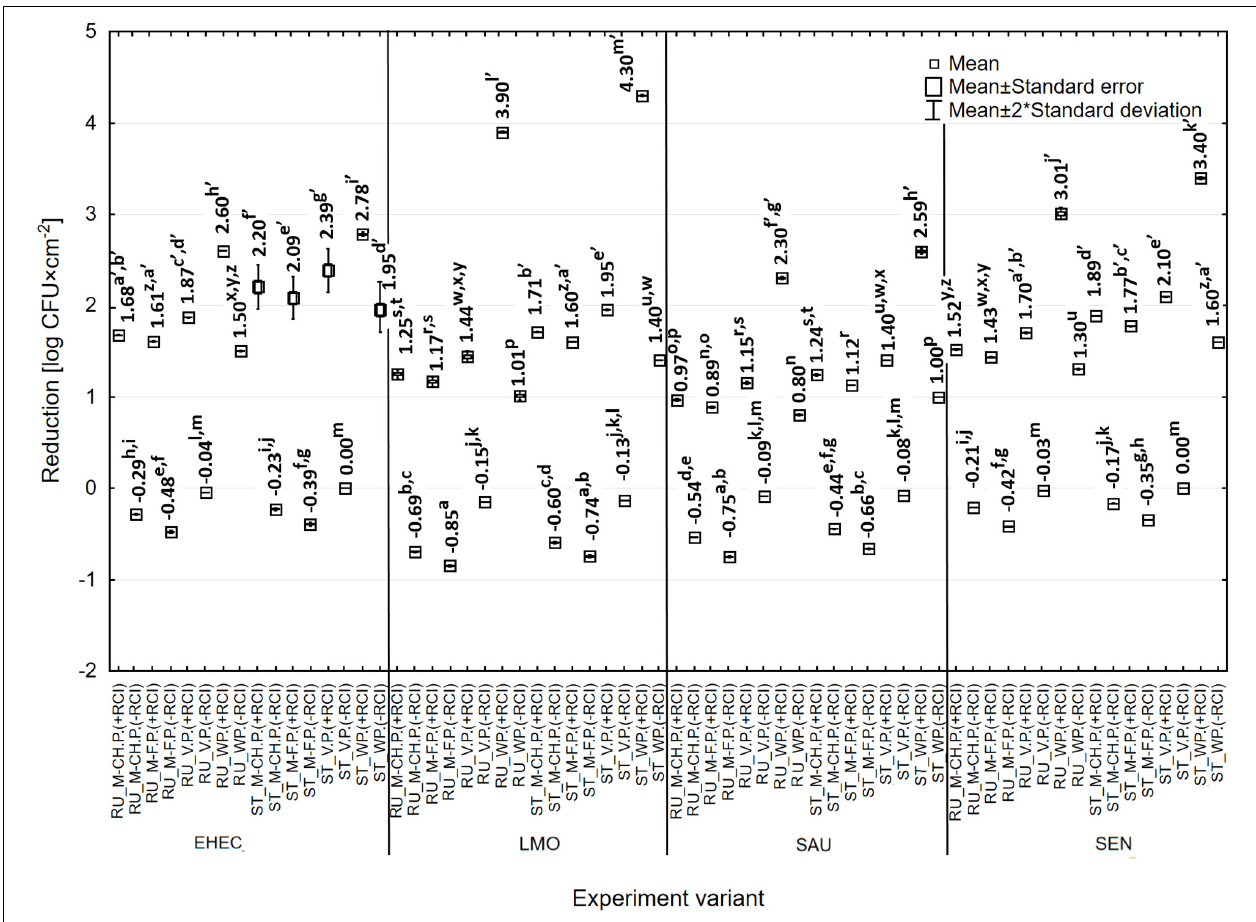
FIGURE 9 | Reduction in the number of bacteria under the influence of RCI depending on the organic pollution [RU – rubber, ST – stainless steel, M-CH.P. – milk-cheese pulp, M-F.P. – meat-fish pulp, V.P. – vegetable pulp, WP – without pulp, +RCI – with RCI, -RCI – without RCI; a, b, c – values marked with different letters are significantly different ( P < 0.05); EHEC – E. coli O157:H7; LMO – L. monocytogenes ; SAU – S. aureus ; SEN – S .